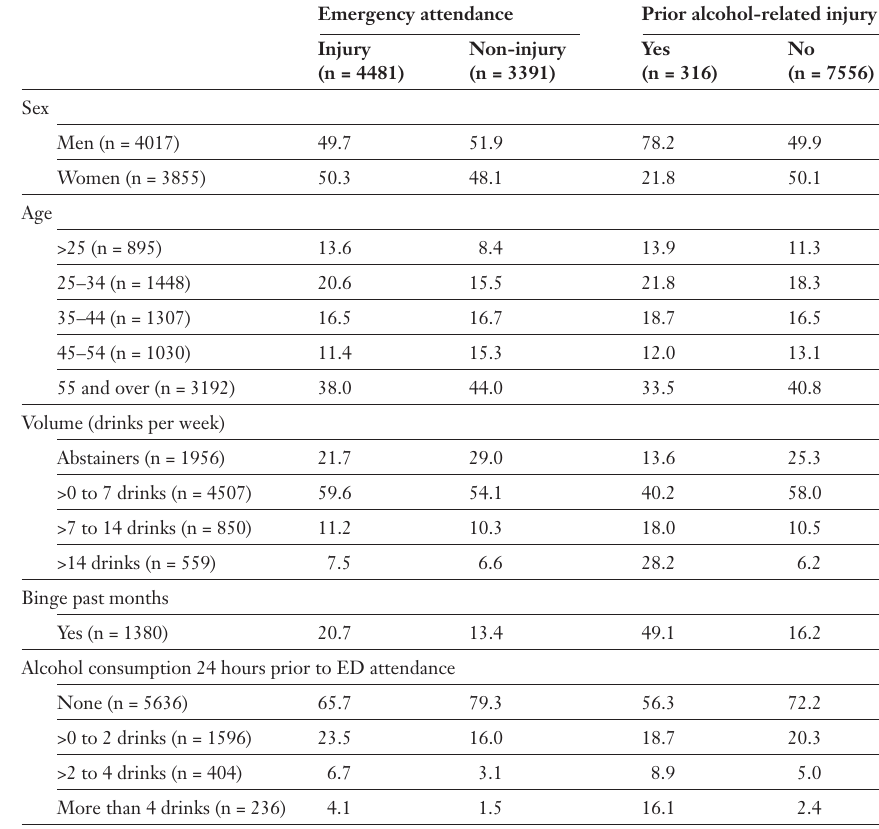
Table 1 Sample characteris- tics of 7,872 patients (%) with current in- jury and prior alco- hol-related injury status.